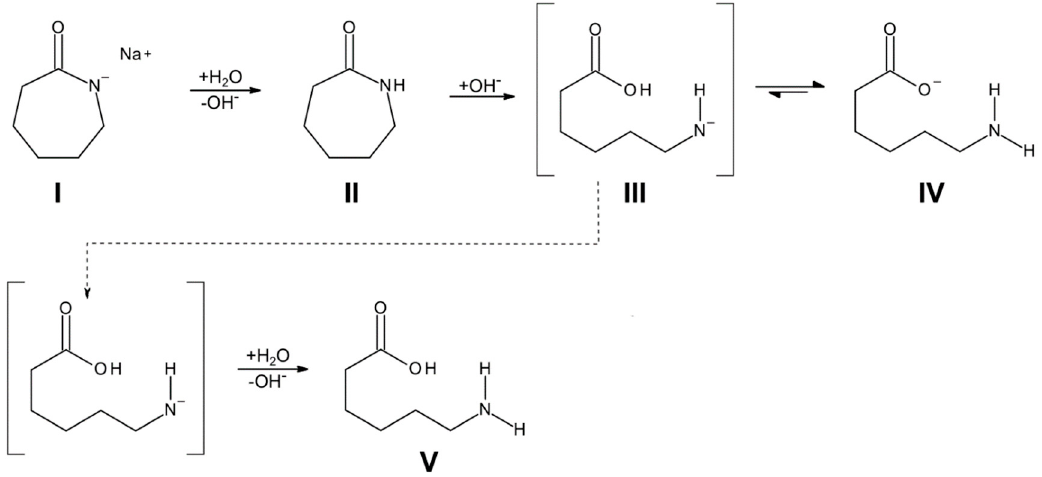
Figure 3. Possible reaction steps for the deactivation of the catalyst sodium caprolactamate (Brüggolen C10) with water.